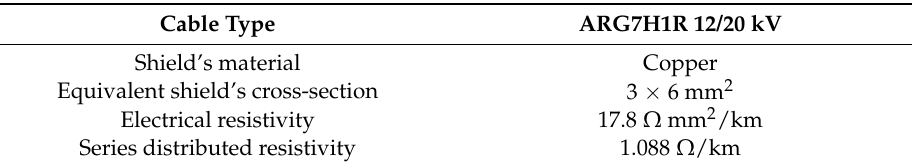
Table 2. MV cables characteristics.